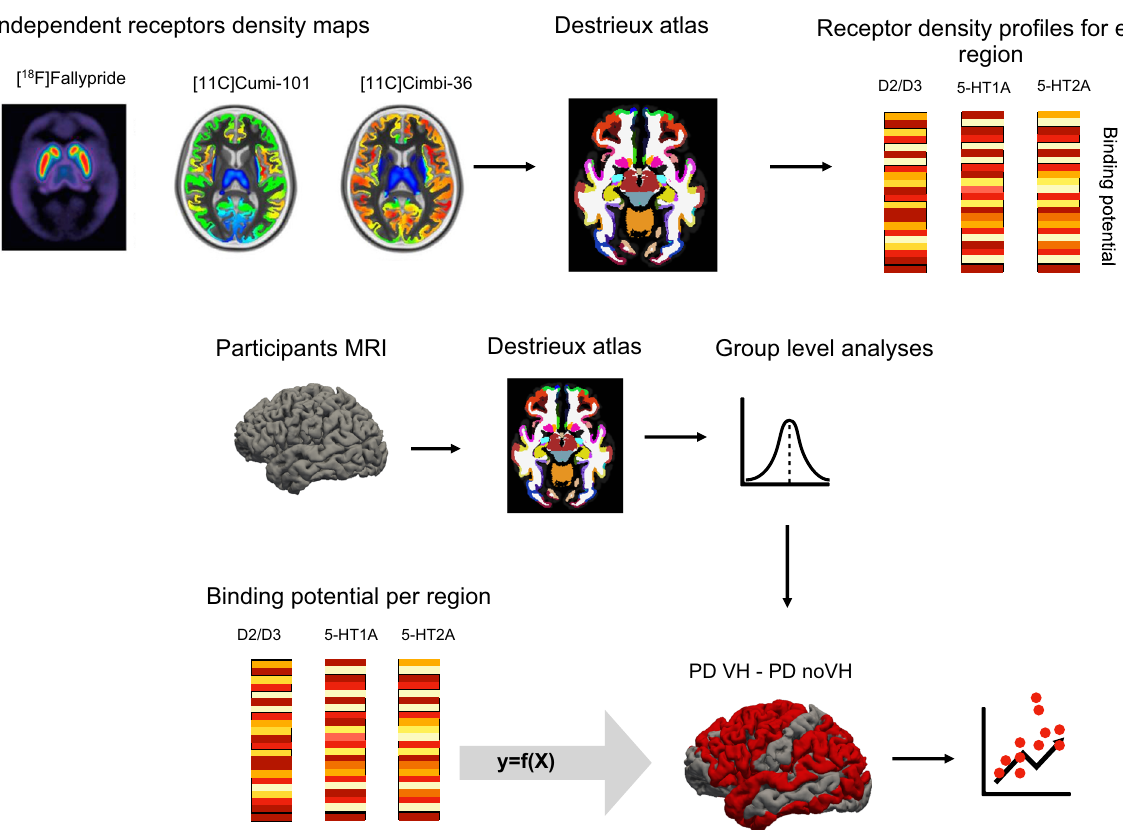
Fig. 2 Receptors density pro fi les: methods. Procedure and rationale of the regression models. Both the independent receptor density maps and our participants ’ MRI scans were parcellated with the Destrieux atlas. Cortical thickness values were extracted for each region of the atlas for the participants ’ scans, and binding potential was extracted for each region of the atlas for the receptor density maps. Each receptor ’ s binding potential was used in separate models as a predictor of difference of the means of thickness between PD-VH (patients with hallucinations) vs. PD-noVH (without